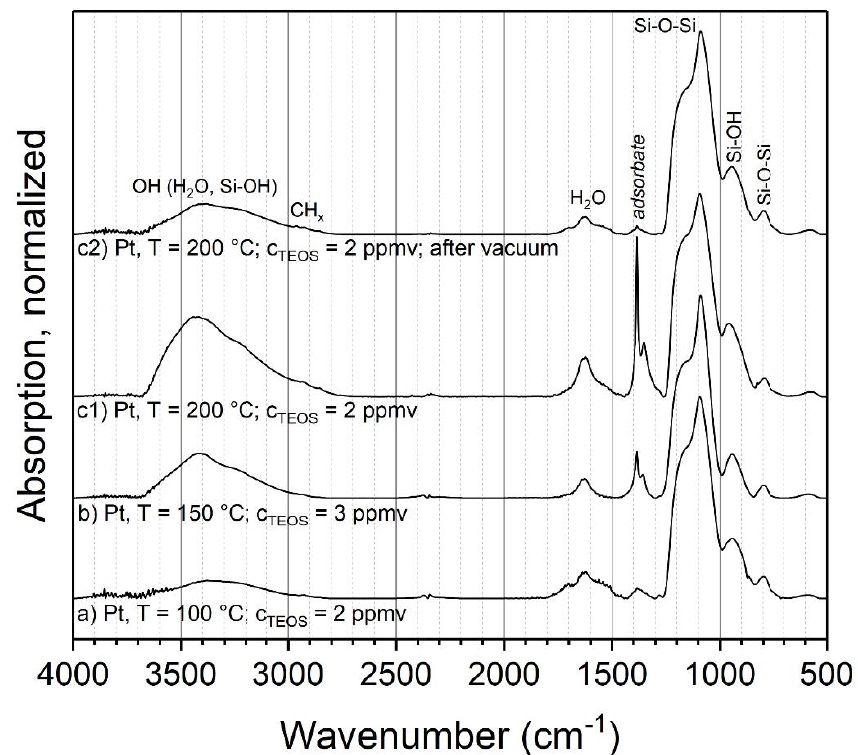
Figure 6. FTIR spectra of coatings with TEOS as the precursor at elevated temperatures.